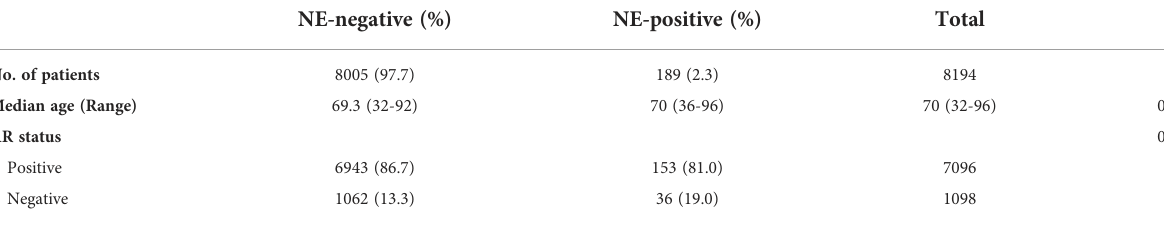
TABLE 2 Summary of AR status in 8194 pathology-con fi rmed prostate cancer